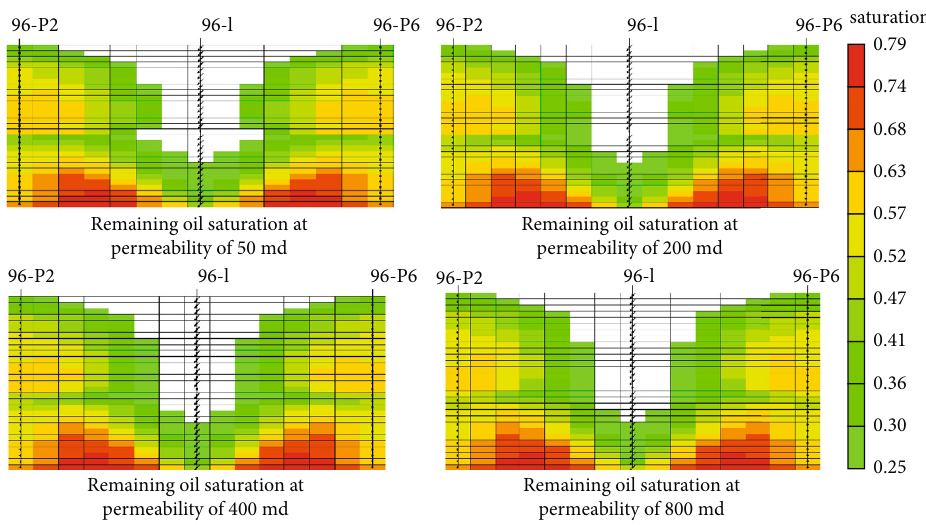
Figure 6: Remaining oil saturation pro fi les simulated under di ff erent interlayer permeabilities after steam fl ooding for 5400 days. A constant steam quality of 0.3 was used in these